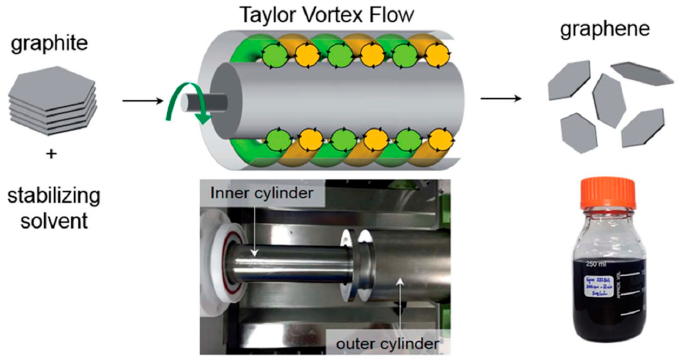
Figure 28. Schematic of the shear-exfoliation of graphite into few-layer graphene by a Taylor Vortex flow. Photographs shows a Taylor-Couette flow reactor and the graphene dispersions produced by shear exfoliation. Reproduced from [55]. Copyright Royal Society of Chemistry, 2016.